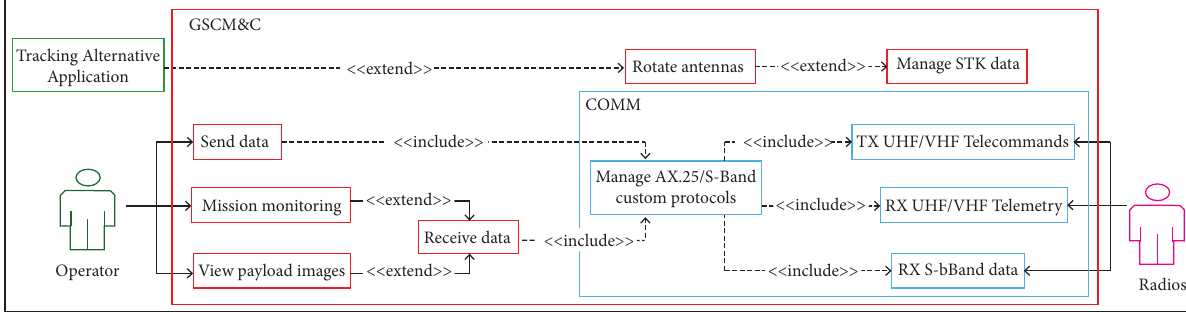
figure 12. GSCM&C general use